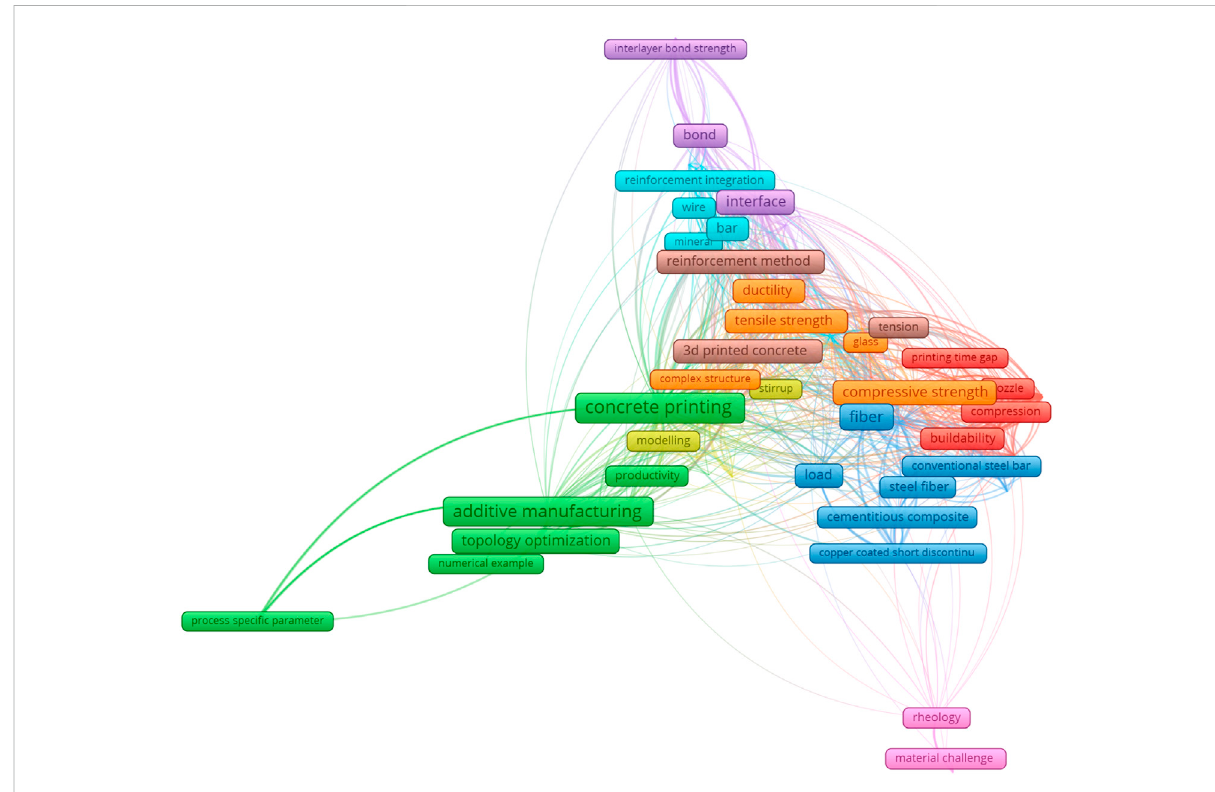
FIGURE 2 Bibliometric network obtained for the publications searched through